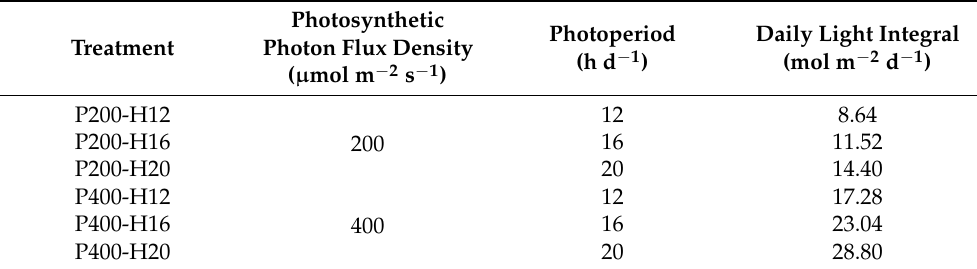
Table 1. Light environment setting with photosynthetic photon flux density (P) and photoperiod (H) for cucumber seedlings grown in the closed transplant production system for 21 days after sowing.